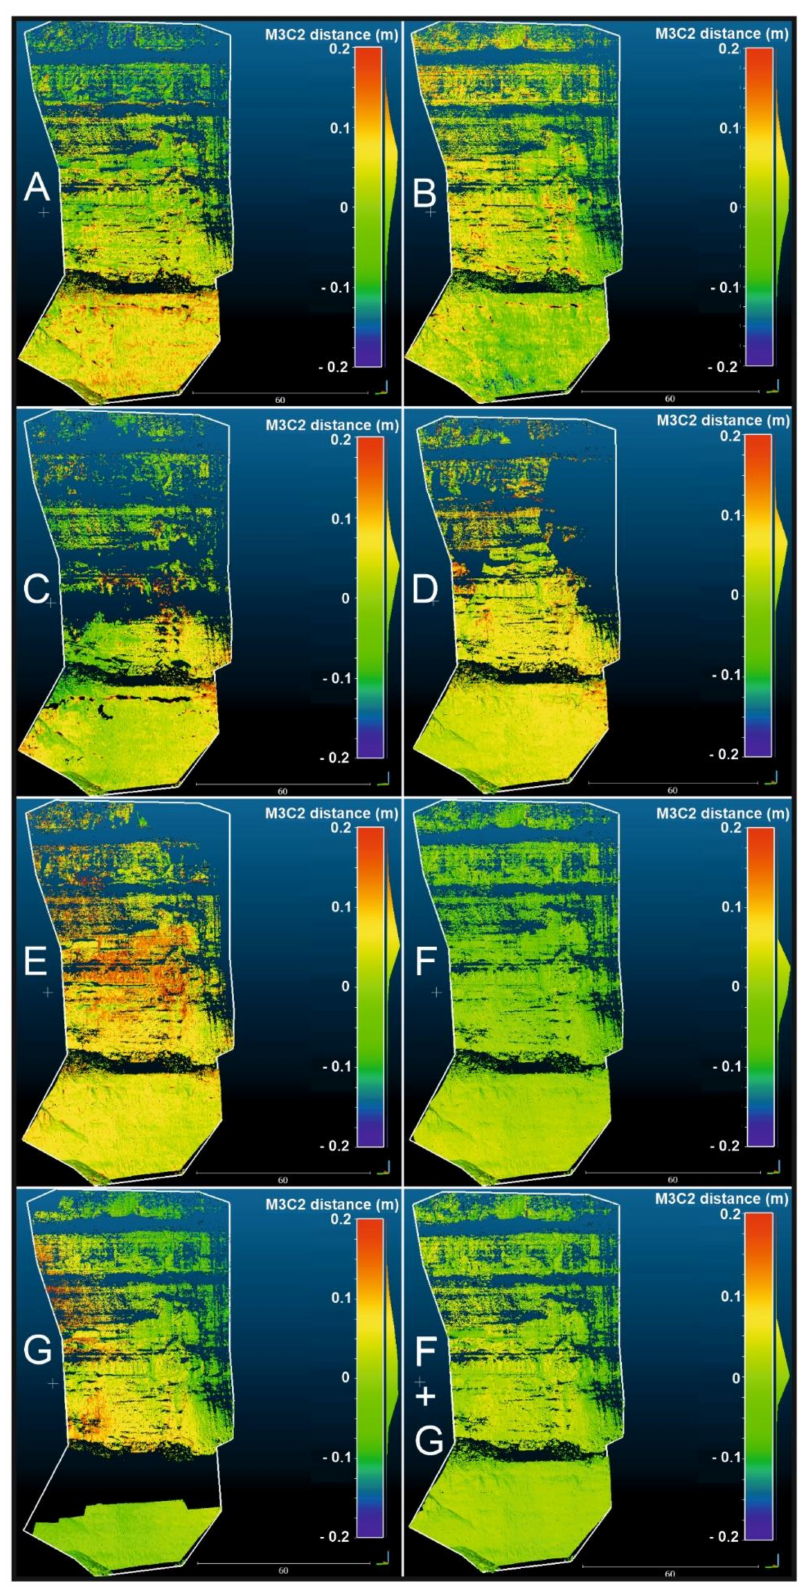
Figure 7. Comparison of data quality with the TLS algorithm of Cloud Compare by using the TLS point cloud as reference. ( A ) AMSL-nadir; ( B ) AMSL-40 ◦ off-nadir; ( C ) AGL-nadir; ( D ) AGL-40 ◦ off-nadir, ( E ) AGL-Point of Interest; ( F ) facade-nadir; ( G ) facade-40 ◦